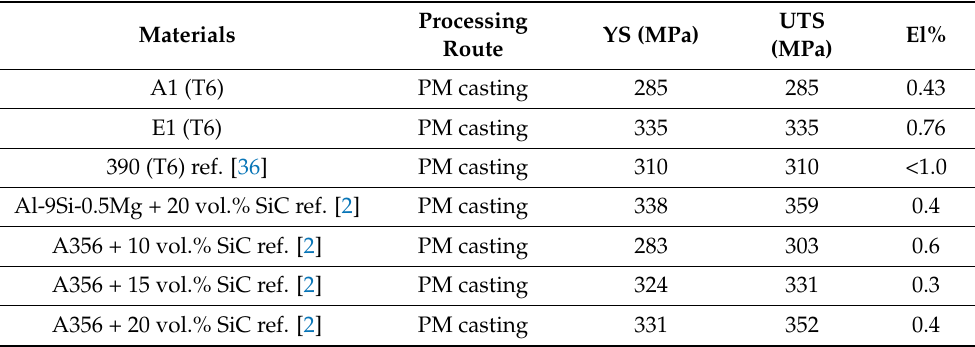
Table 4. Comparison of the tensile properties of examined alloys with existing studied and commer- cial alloys. UTS Processing El% YS (MPa) Materials (MPa) Route A1 (T6) PM casting 285 285 0.43 E1 (T6) PM casting 335 335 0.76 390 (T6) ref. [36] PM casting 310 310 <1.0 Al-9Si-0.5Mg + 20 vol.% SiC ref. [2] PM casting 338 359 0.4 A356 + 10 vol.% SiC ref. [2] PM casting 283 303 PM casting 324 331 A356 + 20 vol.% SiC ref. [2] PM casting 331 352